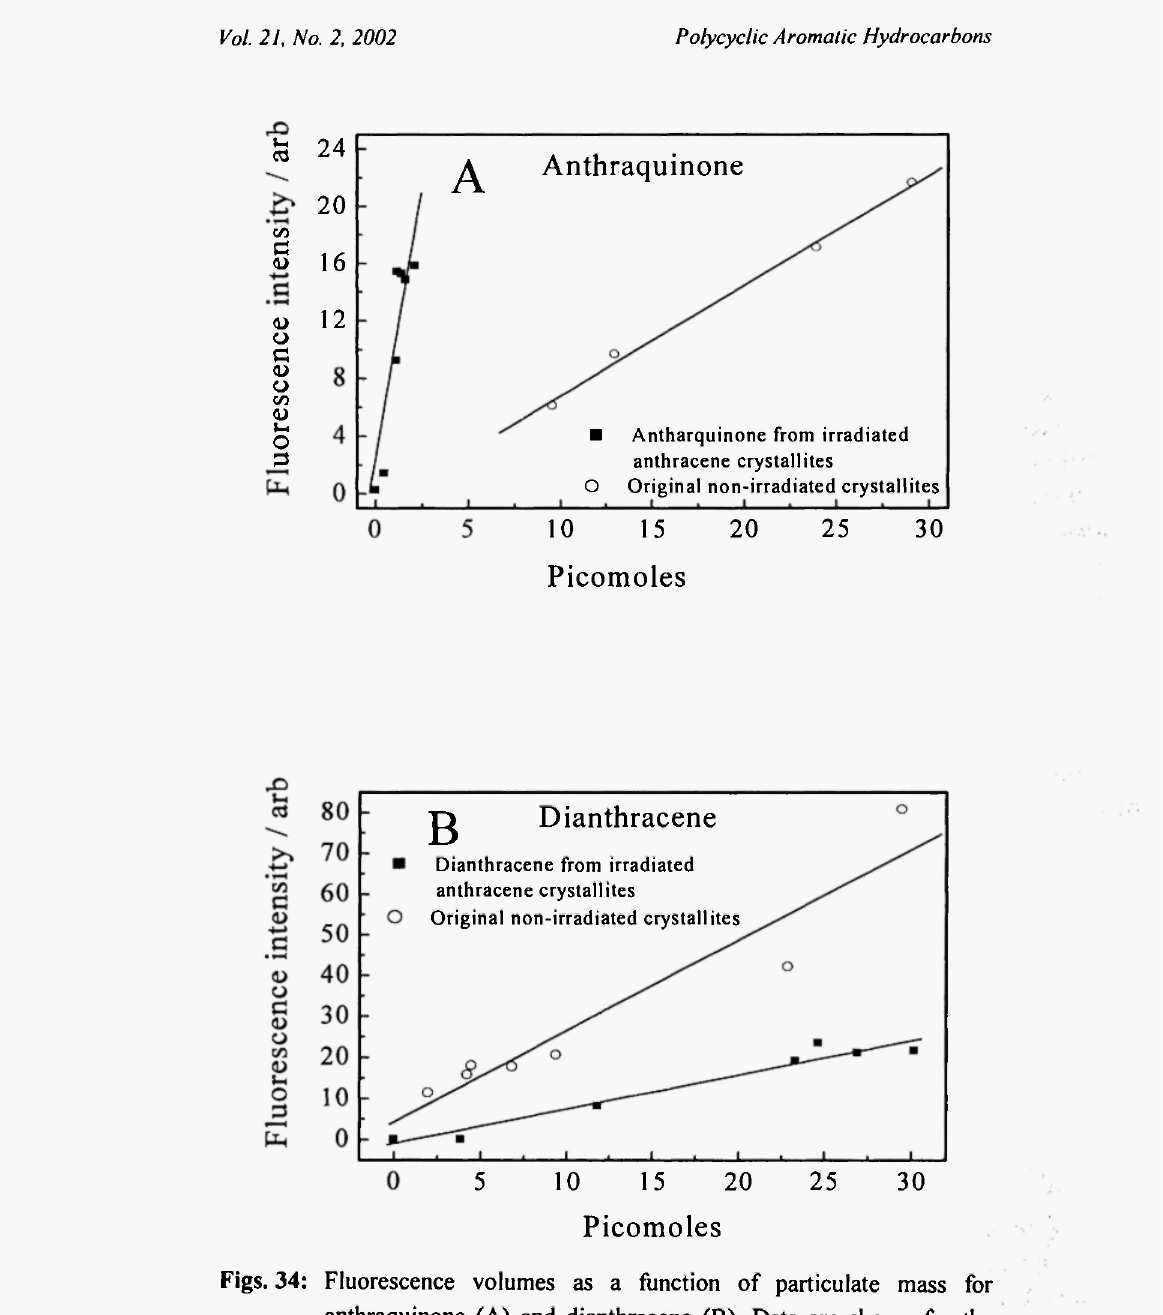
Figs. 34: Fluorescence volumes as a function of particulate mass for anthraquinone (A) and dianthracene (B). Data are shown for the pure original material and for that produced photo-chemically, entrapped in a three-composite crystalline